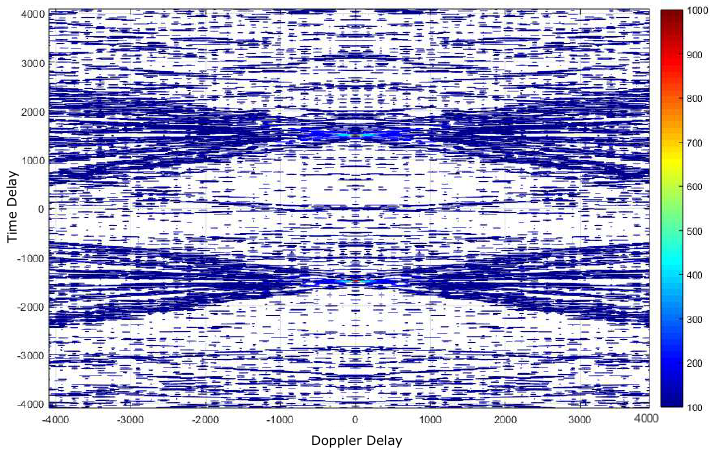
Figure 19. Two nearby scatterers using chirp pulses (MMPP): 2D, at − 5 dB